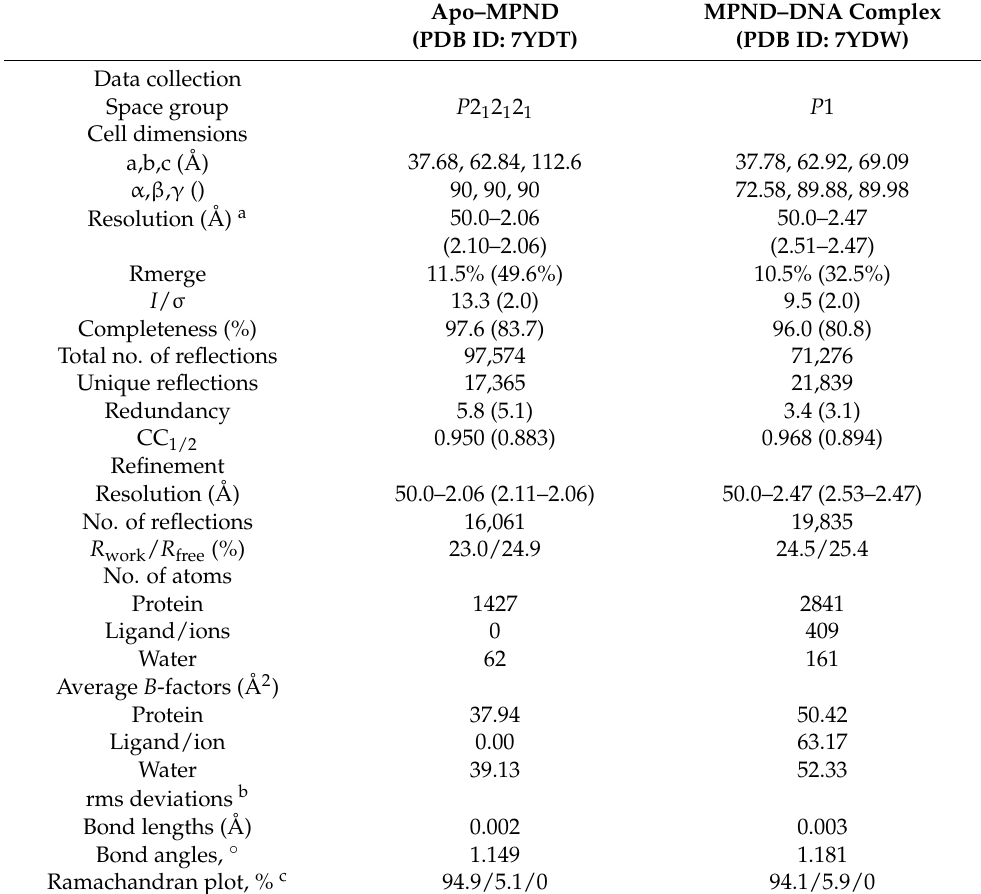
Table 1. Data collection and refinement statistics of apo–MPND and MPND–DNA